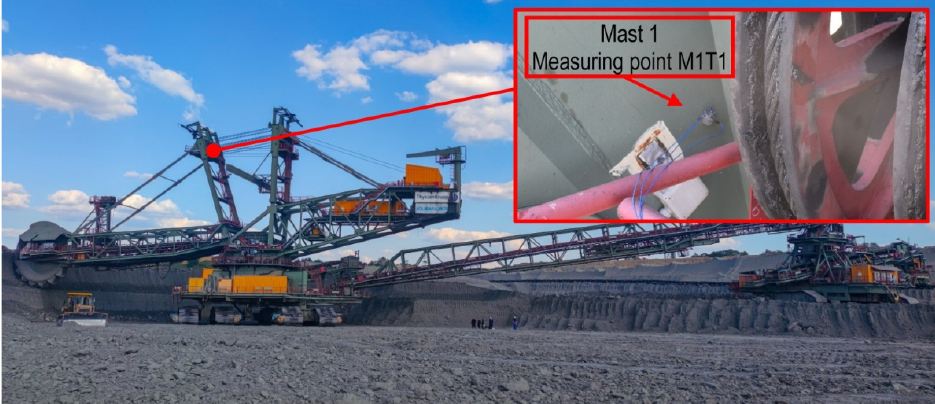
Figure 17. BWE SchRs 1600 during the measurements (conducted on 16 June 2021) and detail of the measurement point M1T1.